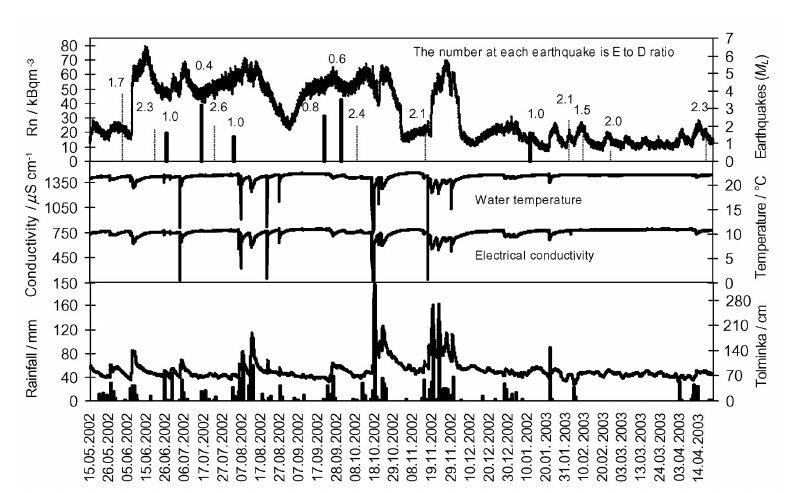
Fig. 2. Geochemical data measured in the thermal spring at Zatolmin between May 2002 and April 2003. The first diagram (starting from the top) shows radon concentration (kBqm –3 ) and earthquakes ( M L ). E is the distance between the measuring station and the epicentre, while is D the strain radius. Earthquakes with E / D ≤ 1 are drawn with bold lines and those with E / D > 1 with dashed lines. The second diagram shows electrical conductivity ( µ Scm –1 ) and wa- ter temperature (°C), and the third diagram shows rainfall (mm) and the level of the Tolminka River (cm).